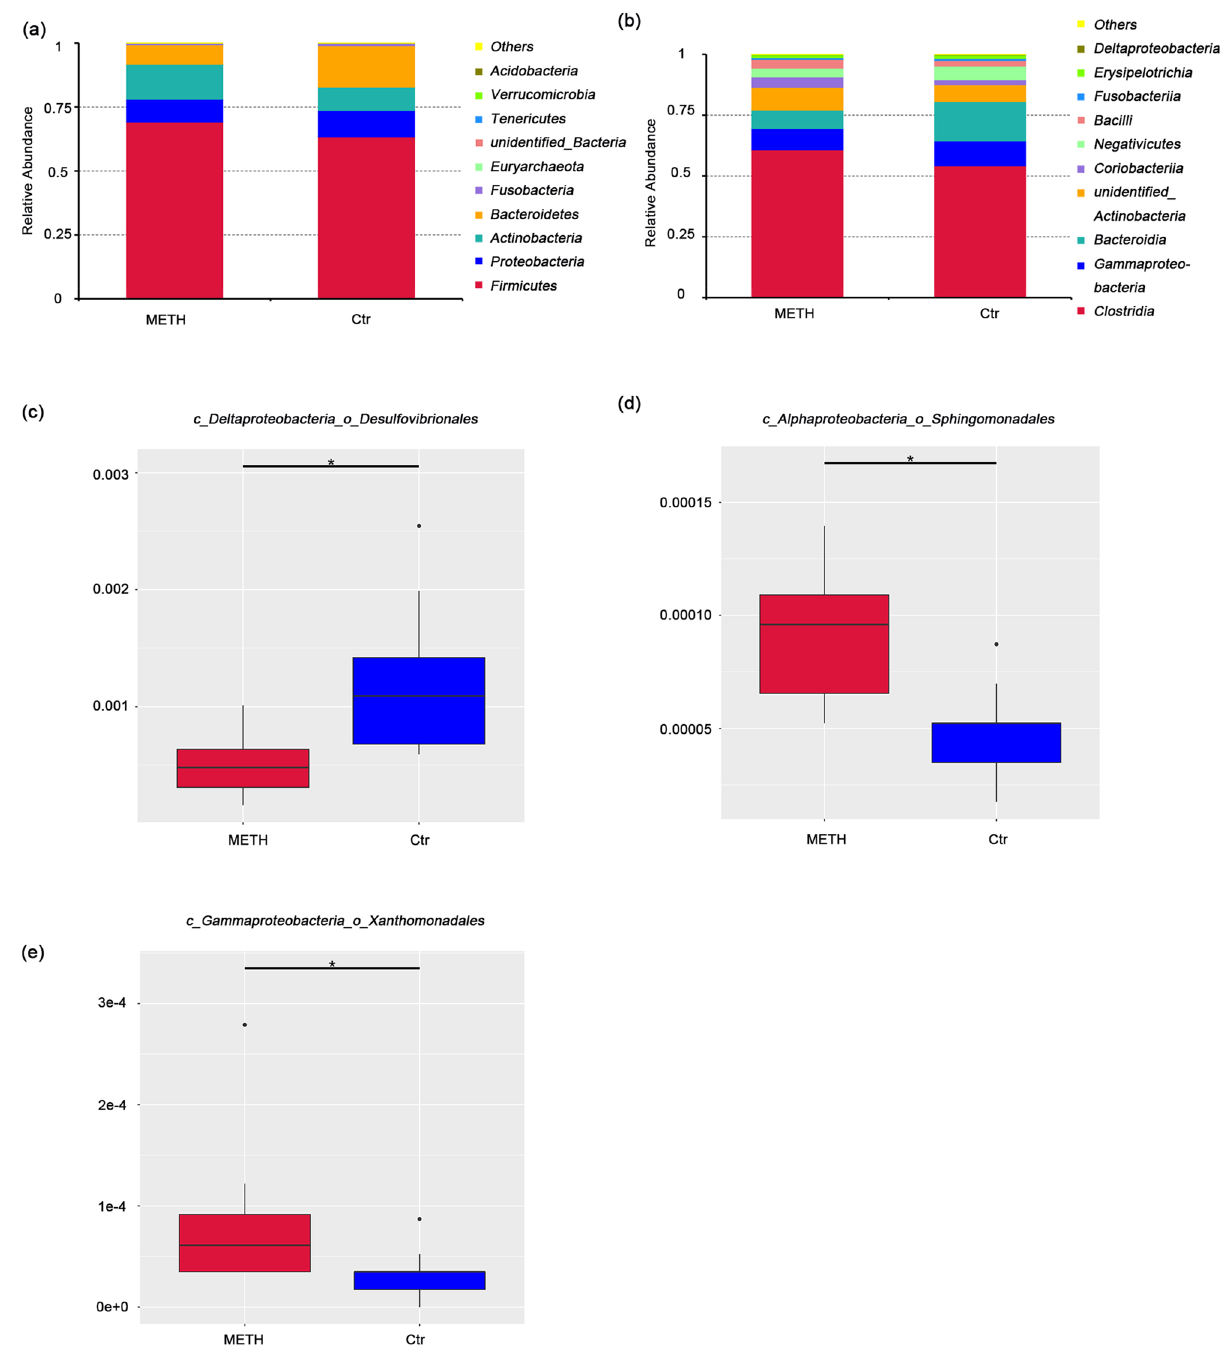
Figure 2. Composition of gut microbiota in the METH and control groups. Relative abundances of ( a ) phylum- level and ( b ) class-level gut microbial taxa. At the order level, ( c ) Desulfovibrionales was significantly decreased, and ( d ) Sphingomonadales and ( e ) Xanthomonadales were significantly increased in the METH group. * q < 0.05